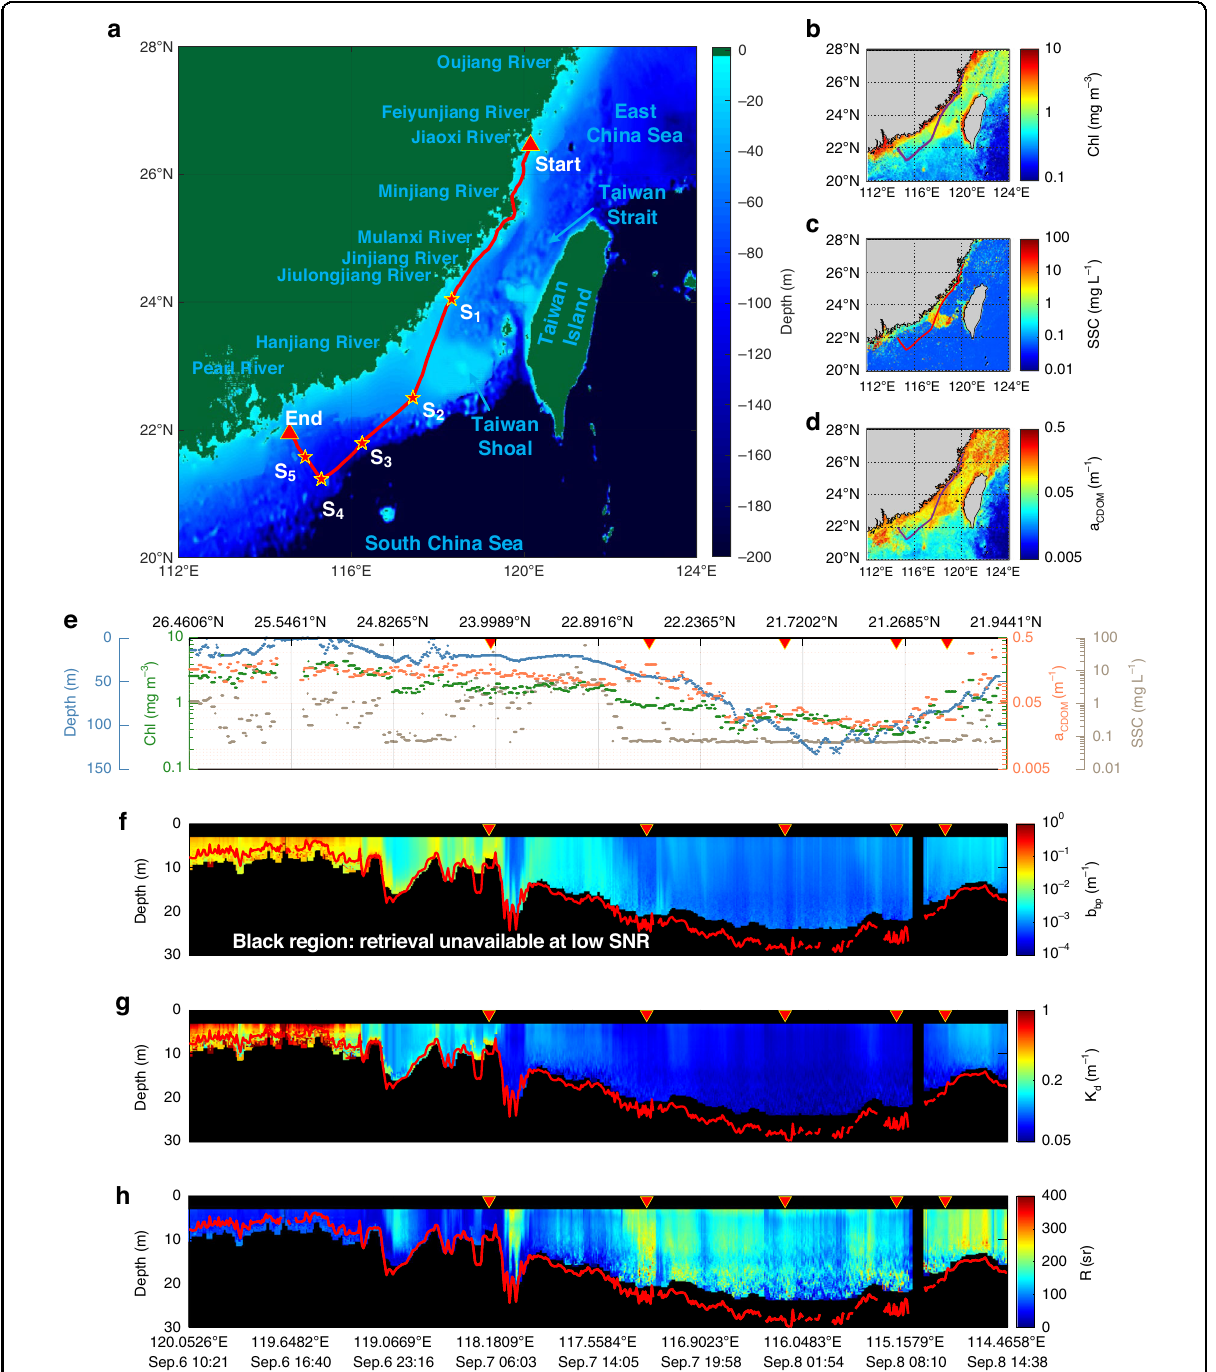
Fig. 3 Continuous underway HSRL measurements (~800 km). Plots of a water depth from ETOPO1, b Chl, c SSC, d a CDOM from HY-1C (Methods) with the ship track represented with the red lines. Discrete in situ measurements were obtained at stations S 1 -S 5 (Methods). e Values along the ship track in Fig. 3a – d. Pro fi les of f b bp , g K d , h R retrieved by HSRL with 3 optical depths in red